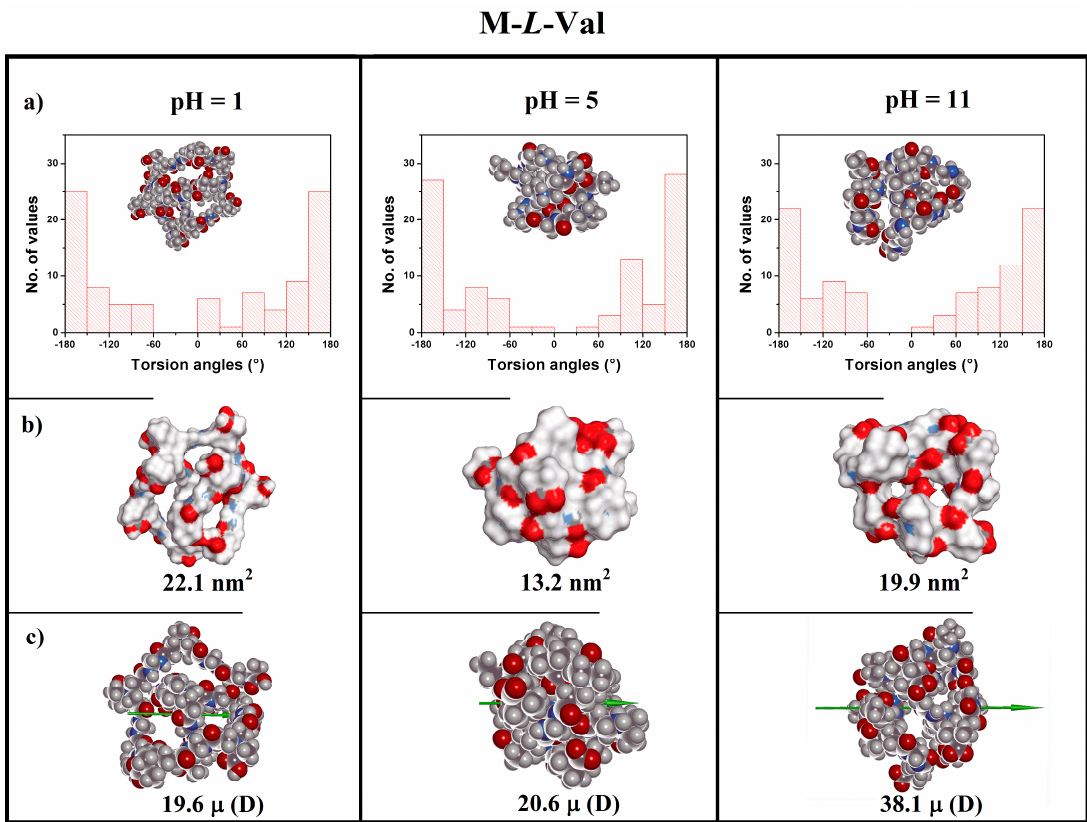
Figure 11. ( a ) Main chain molecular conformations in water at the end of the MD runs for M- L -Val at pH 1, 5 and 11 and torsion angle distributions around the main chain bonds: the histogram are shown with a binning of 30°. Color codes: C atoms dark grey; H atoms light gray; N atoms blue; O atoms red. ( b ) Solvent accessible surface area in water. The surface area is in dark grey near C atoms, in light gray near H atoms, in blue near N atoms and in red near O atoms. ( c ) Dipole moments in water. Color codes are the same as in row ( a ).